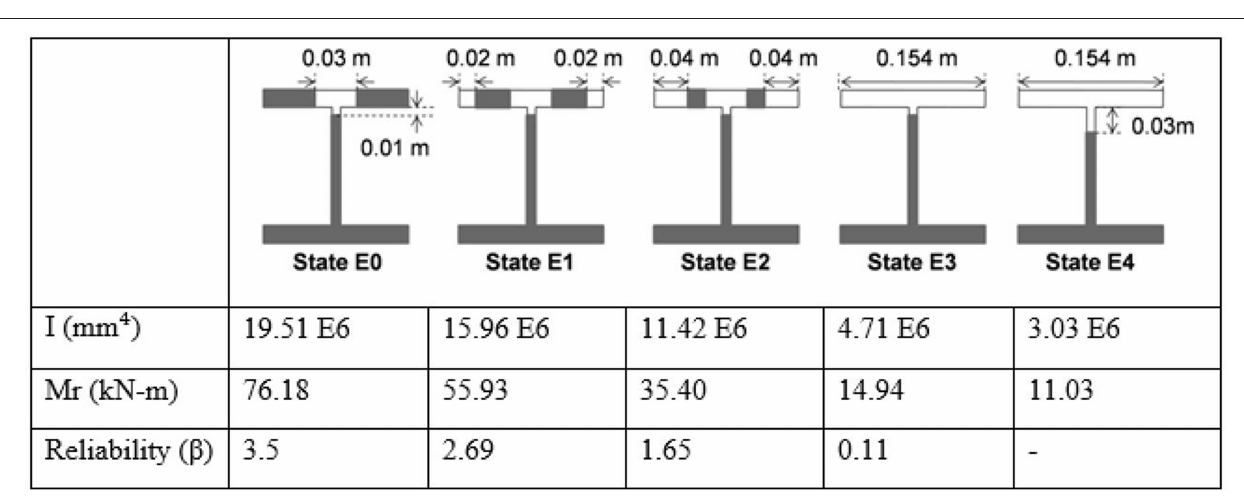
FIGURE 2 | Incremental damage levels and sectional properties of the beam (F y